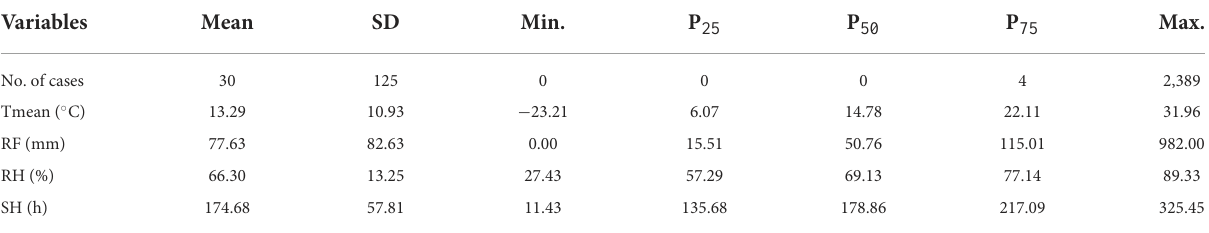
TABLE 2 Descriptive statistics for monthly scrub typhus cases and weather conditions in China from 2006 to 2018 ( n =